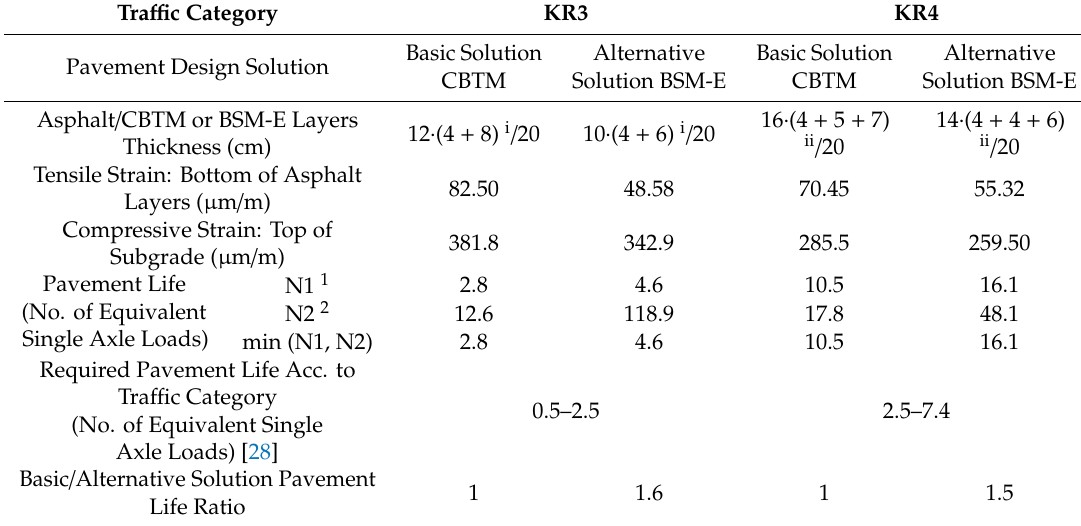
Table 5. Alternative design solutions for flexible pavements with BSM-E base